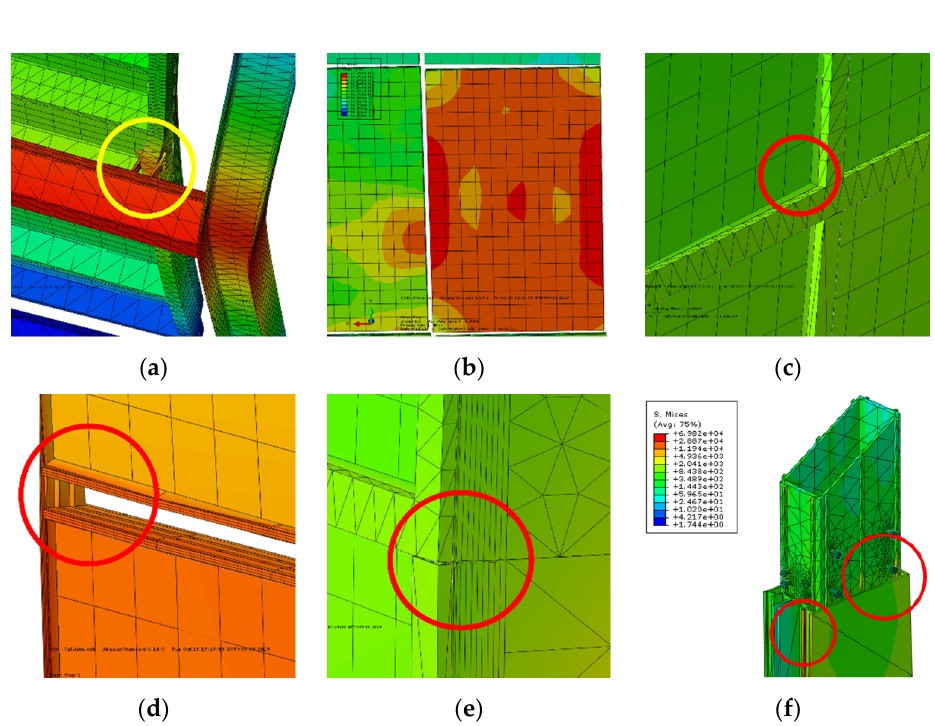
Figure 19. Major vulnerabilities of conventional curtain wall simulation: ( a ) mullion-to-fastener con- nection twist; ( b ) stress concentration on the edge of the glass; ( c ) aluminum frame fallout from the glass; ( d ) gasket twist; ( e ) expansion joint detachment; ( f ) stress concentration at expansion joint connection.